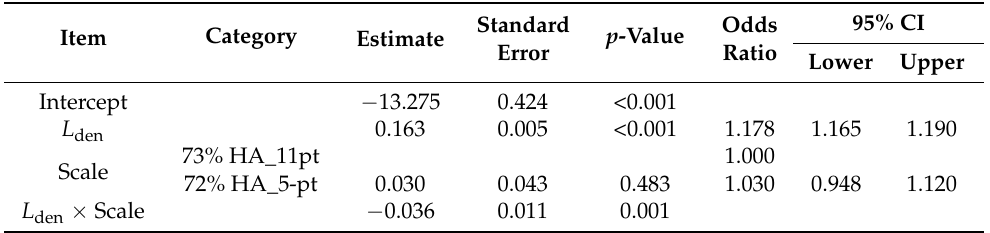
Table 8. Multiple logistic regression analysis of road traffic noise surveys from 2005 to 2013 in Vietnam (AUC =